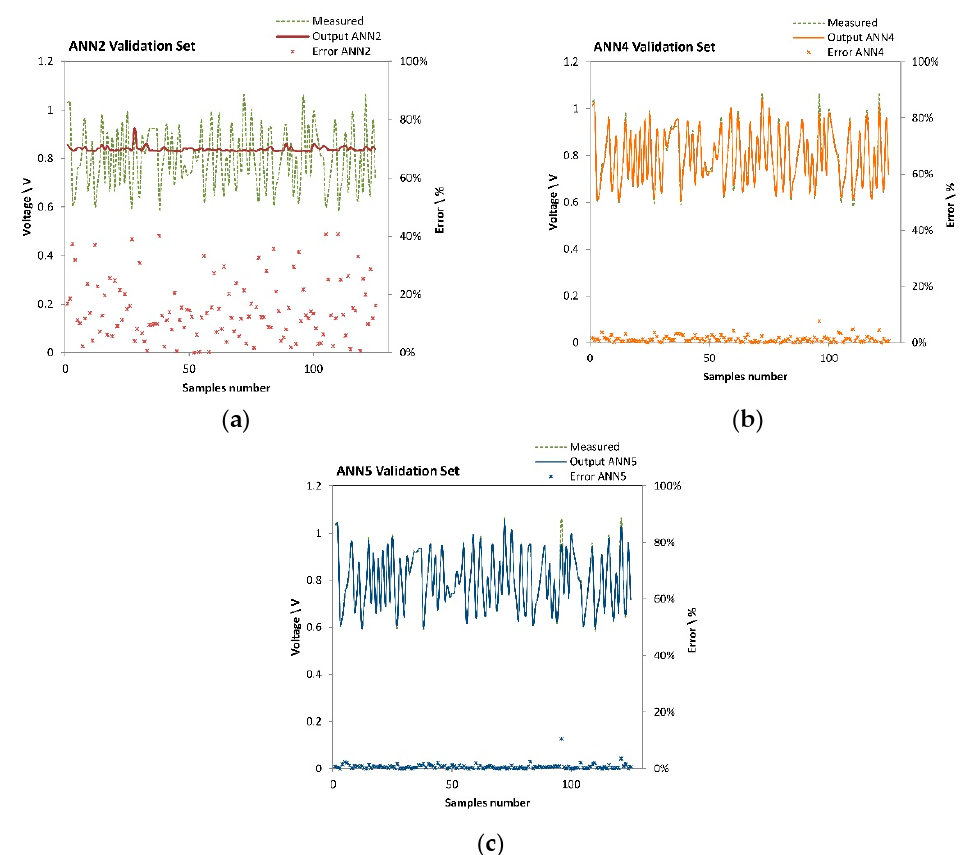
Figure 4. Validation of ANN2 ( a ), ANN4 ( b ) and ANN5 ( c ): error dispersion.